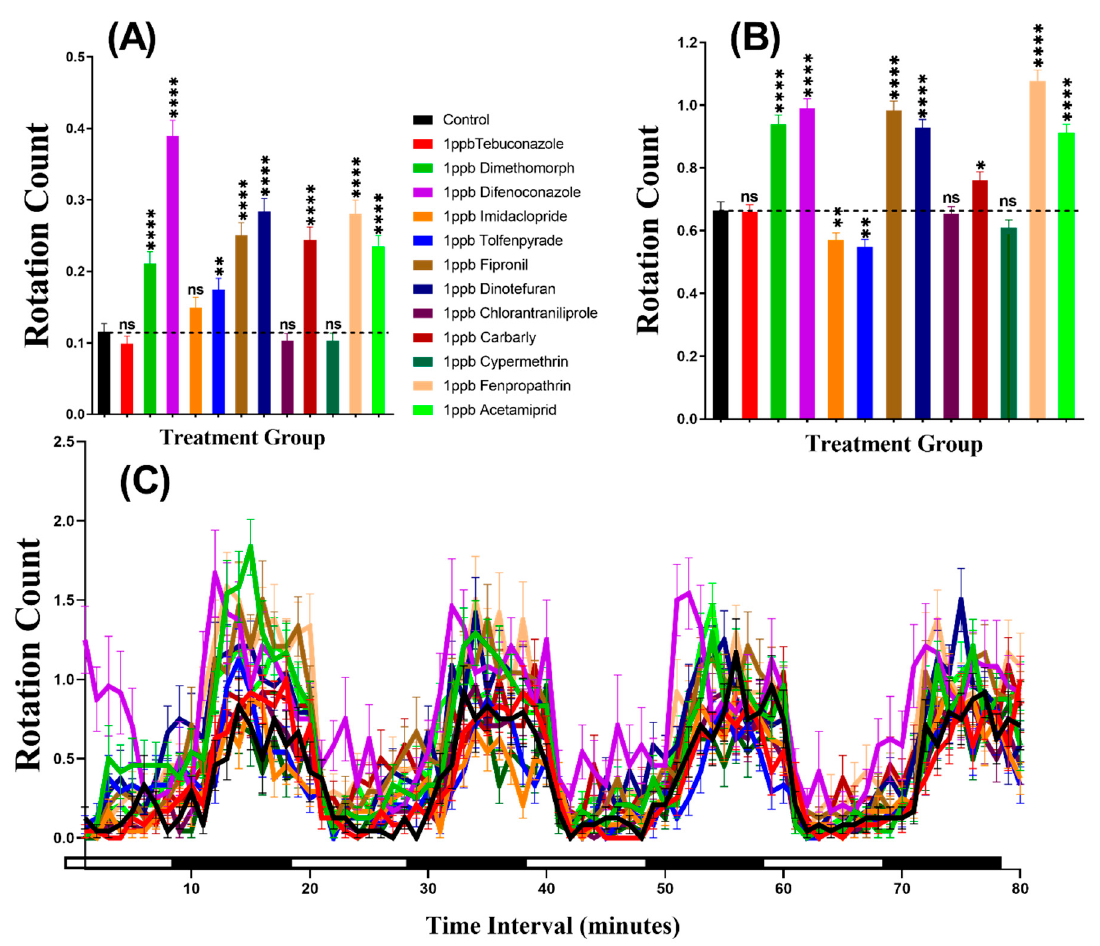
Figure 4. Total rotation count of zebrafish larvae in the control and 1 ppb pesticide treatment after 24-h exposure. ( A ) Total rotation count during the light cycle. ( B ) Total rotation count during the dark cycle. ( C ) The pattern of rotation count during light / dark transition. The data are expressed as the Mean ± SEM and they were analyzed by Two-way ANOVA and Brown–Forthsythe and Welch ANOVA test. Dunnett’s multiple comparison test for comparing all treatments with control was carried out to observe the column (pesticide) effects ( n = 24; ns = not significant, * p < 0.05, ** p < 0.01, **** p < 0.0001).